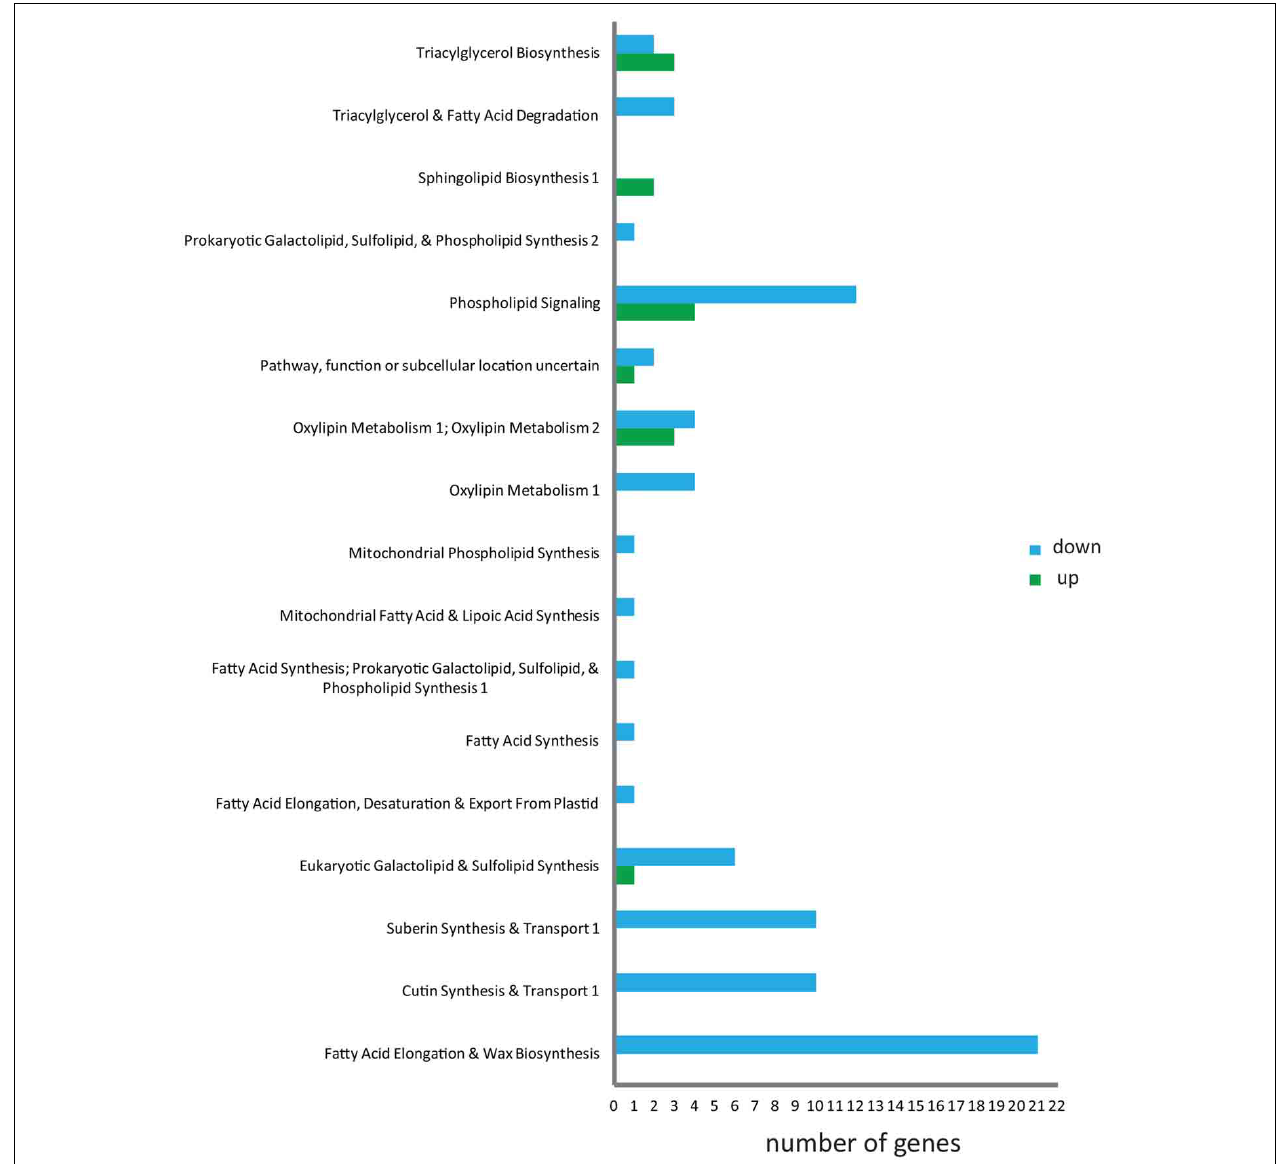
FIGURE 5 | Identification of MGAT1 DEGs involved in acyl-lipid metabolism. Distribution of genes differentially expressed by MGAT1 into different categories of acyl-lipid metabolism is illustrated. Down-regulation